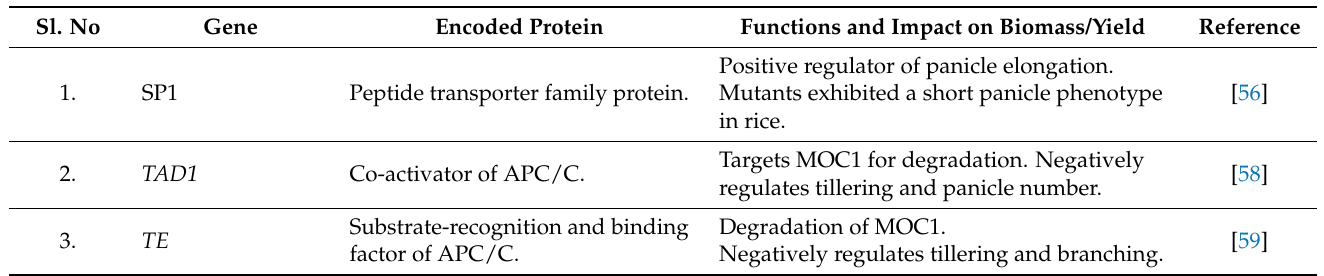
Genes associated with rice canopy and panicle architecture and their impact on